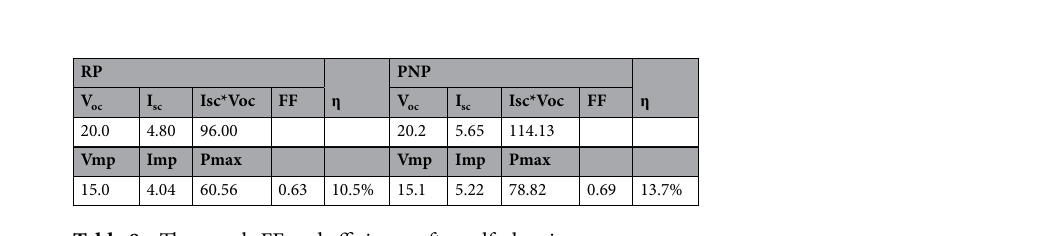
Table 8. The panels FF and efficiency after